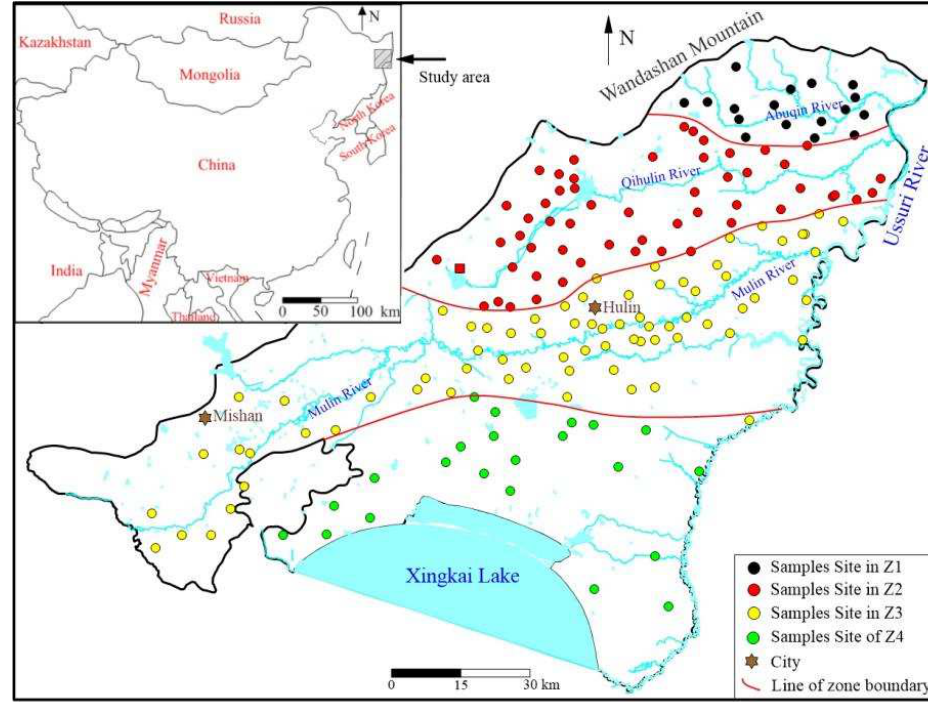
Figure 1. Study area and sampled sites.